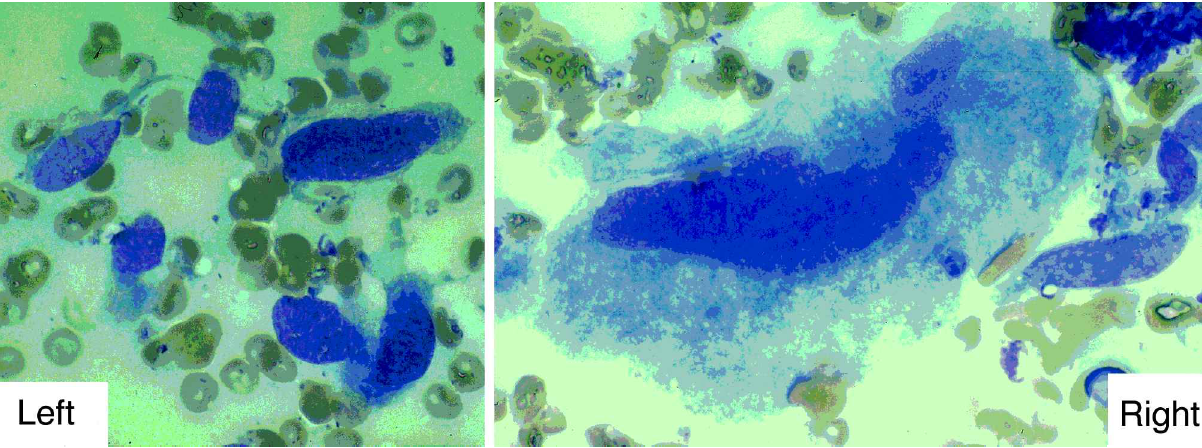
Fig. 4. In pleomorphic, high-grade malignant leiomyosarcoma the typical blunt-ended cigar-shaped nuclei may be found . (MGG 3 1000).